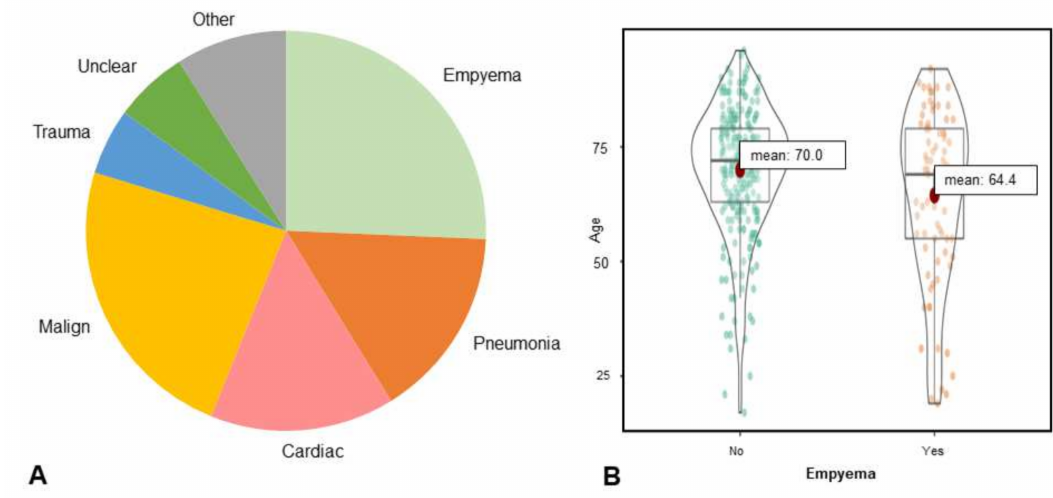
Figure 3. ( A ). The pie chart summarizes the distribution of the different pleural effusion causes ( B ). Shows the age distribution in the